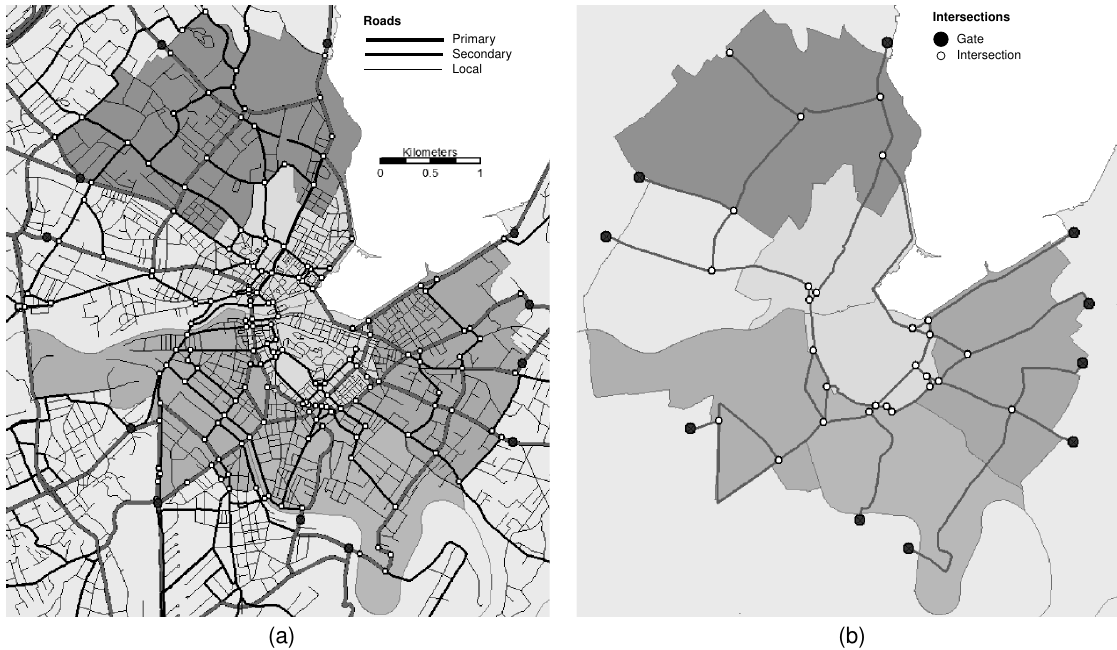
Figure 6. Case study road network: (a) original road network and (b) simplified road